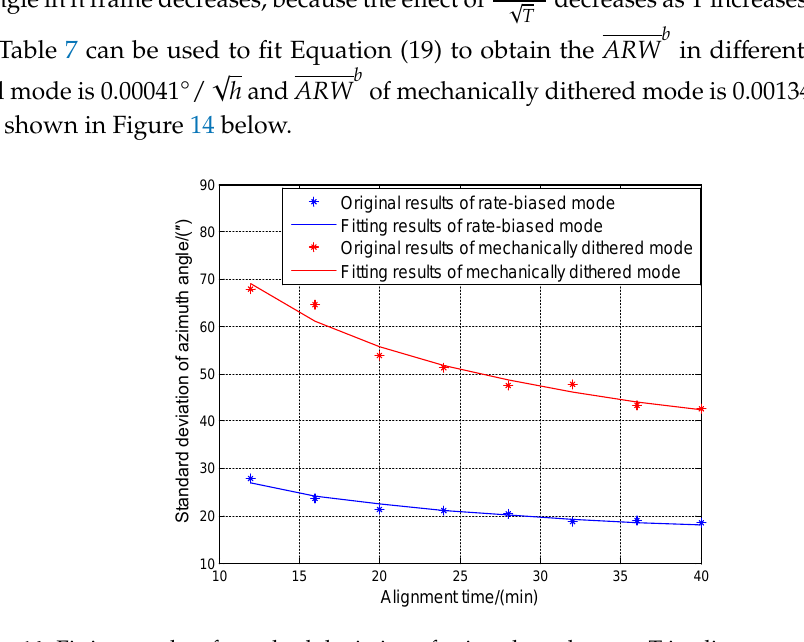
Figure 14. Fitting results of standard deviation of azimuth angle verse T in alignment